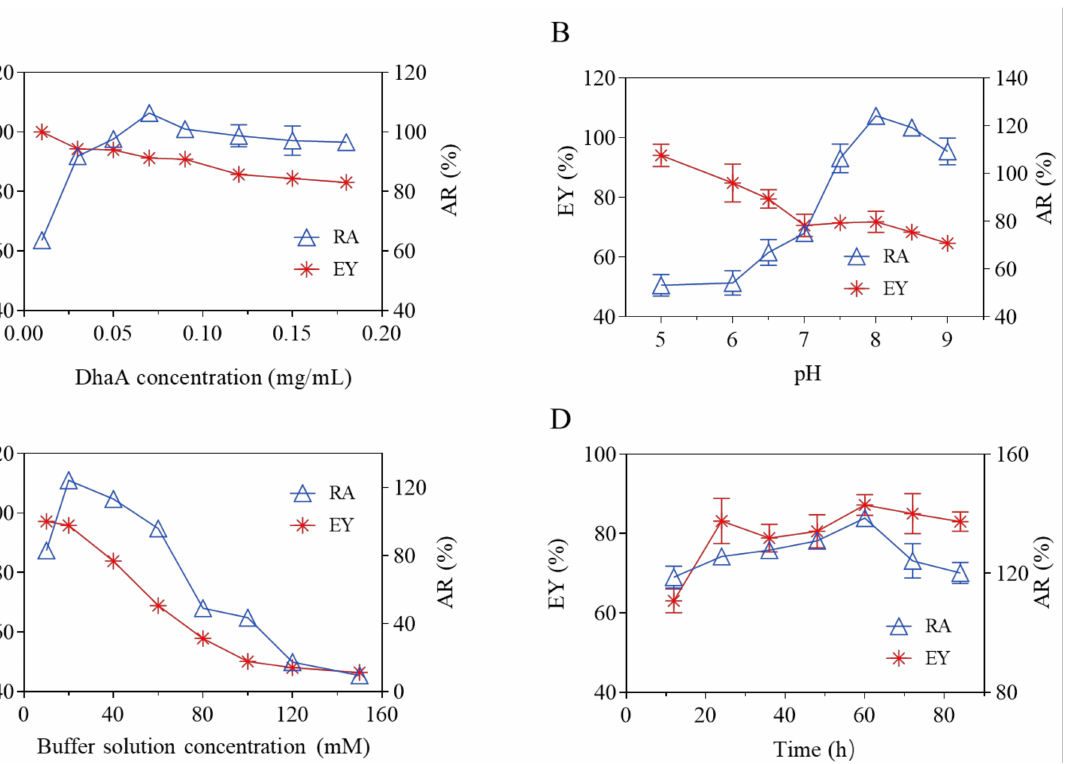
Figure 3. Synthetic process of immobilized enzyme. Effects of DhaA concentration ( A ), pH value ( B ), PB buffer concentration ( C ), and incubation time ( D ) on EY and AR of immobilized